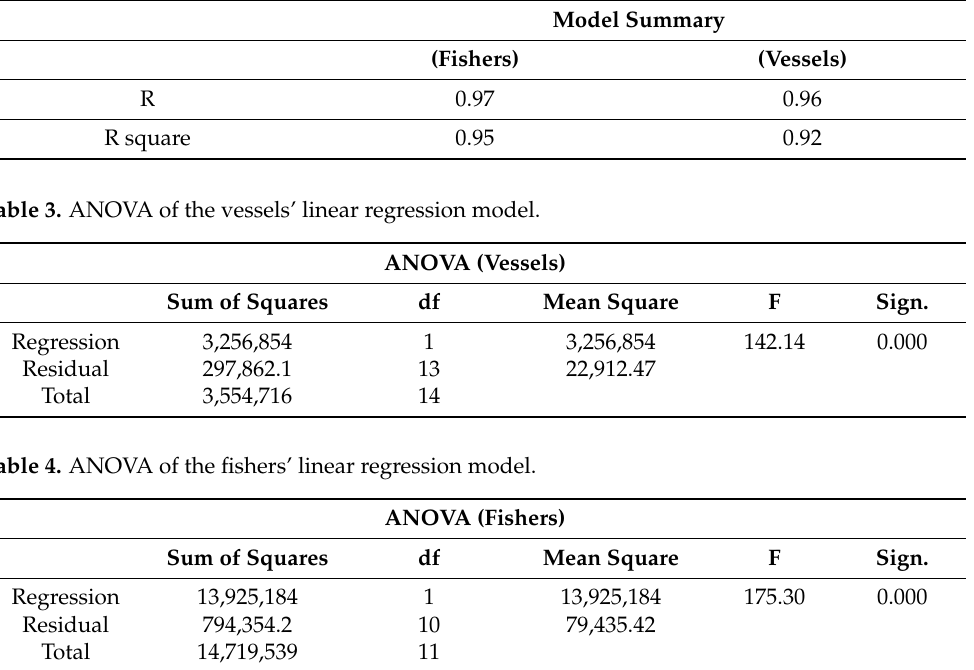
Table 2. Summary of the linear regression models.